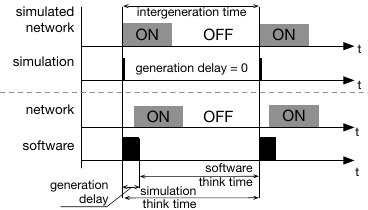
Figure 6: Differences between think times in